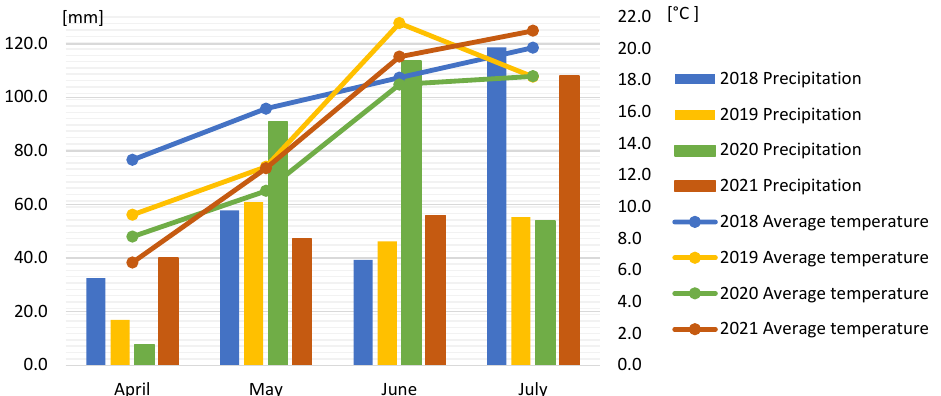
Figure 1. The average monthly air temperature and total precipitation during the experiment in 2018–2021 at experimental orchard in Dąbrowice near Skierniewice.